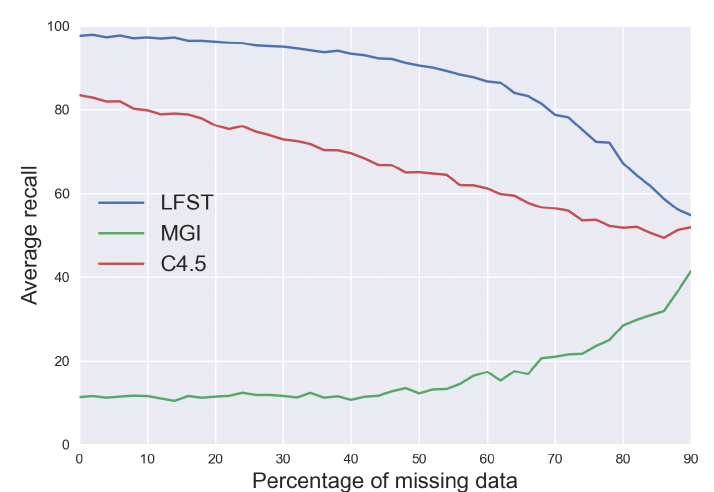
Figure 13. Comparison of the average recall in 421World.